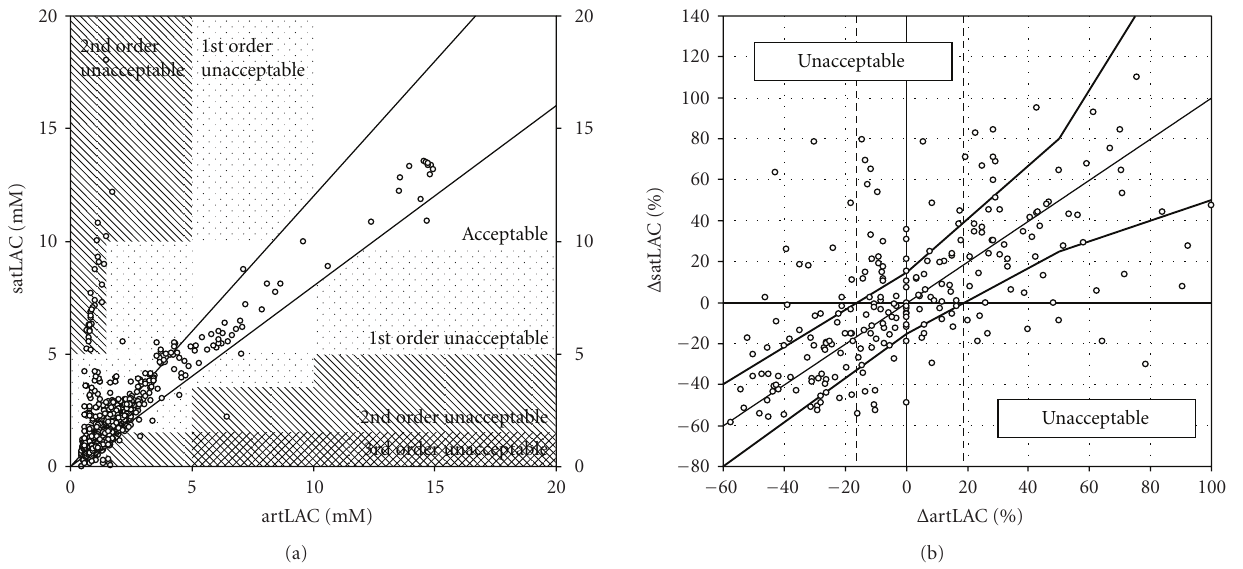
Figure 1: (a) Clinical evaluation of absolute lactate levels from subcutaneous adipose tissue ( sat LAC) on the y -axis versus reference measurements from arterial blood ( art LAC) on the x -axis. Clinical lactate grid as described in the method section is indicated as hatched areas. (b) 6-hour lactate trend analysis with respective clinically acceptable and unacceptable ranges as described in the method section. Relative 6-hour lactate trend of reference arterial blood lactate readings ( Δ art LAC) and calibrated subcutaneous lactate readings ( Δ sat LAC) are indicated on x -axis and y -axis, respectively. Upper and lower thick lines represent limits for acceptable lactate trend identification from subcutaneous adipose tissue measurements. Vertical-hatched lines indicate thresholds for decreasing and increasing reference lactate